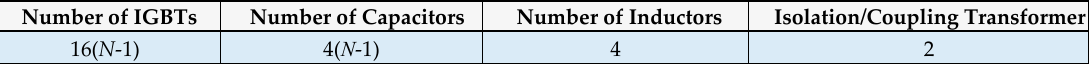
Table 13. Components quantities of the FB-MMC2 RPC.